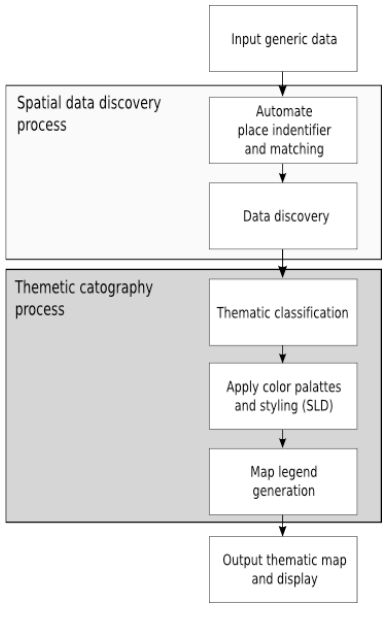
Figure 3. Concept workflow of thematic engine system